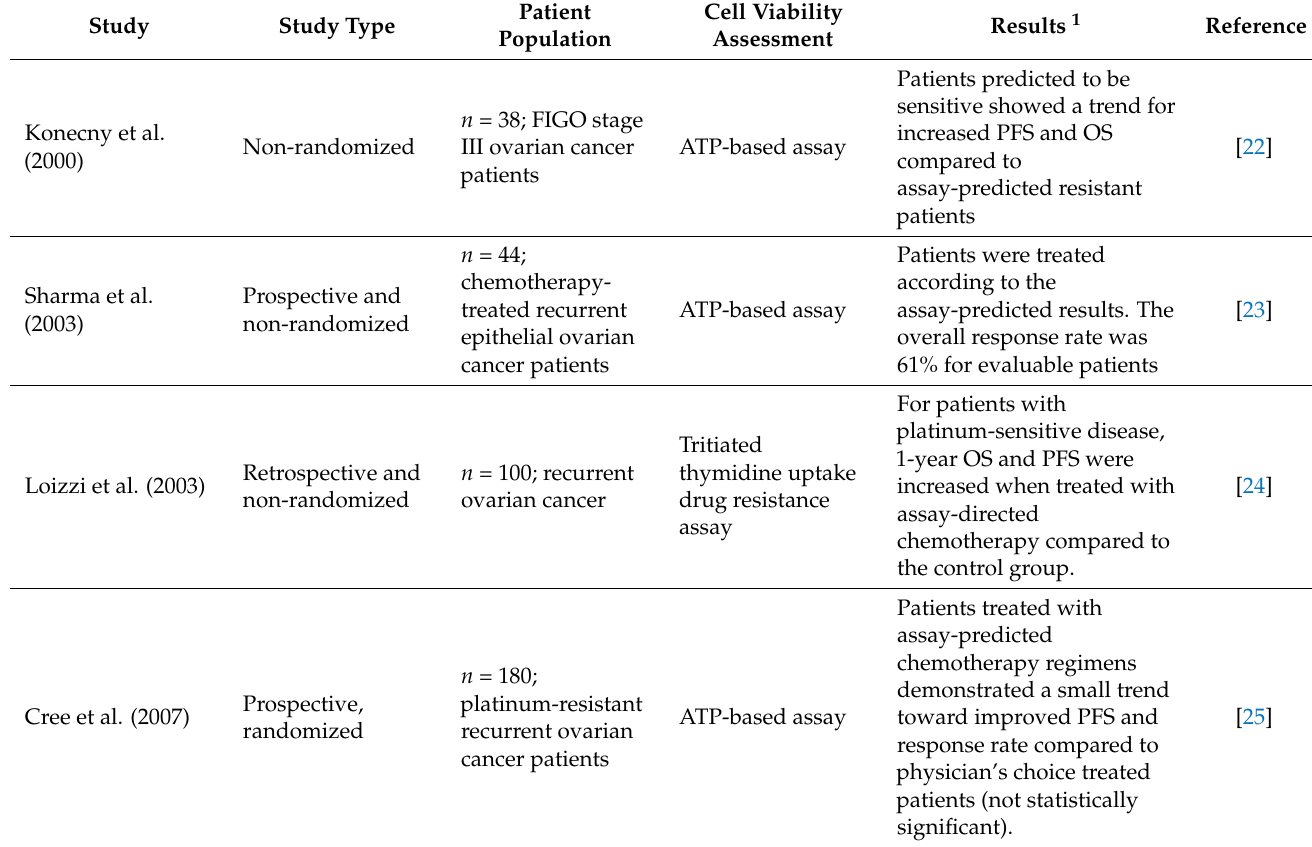
Table 2. Overview of 2D cell culture-based drug-response assays in ovarian